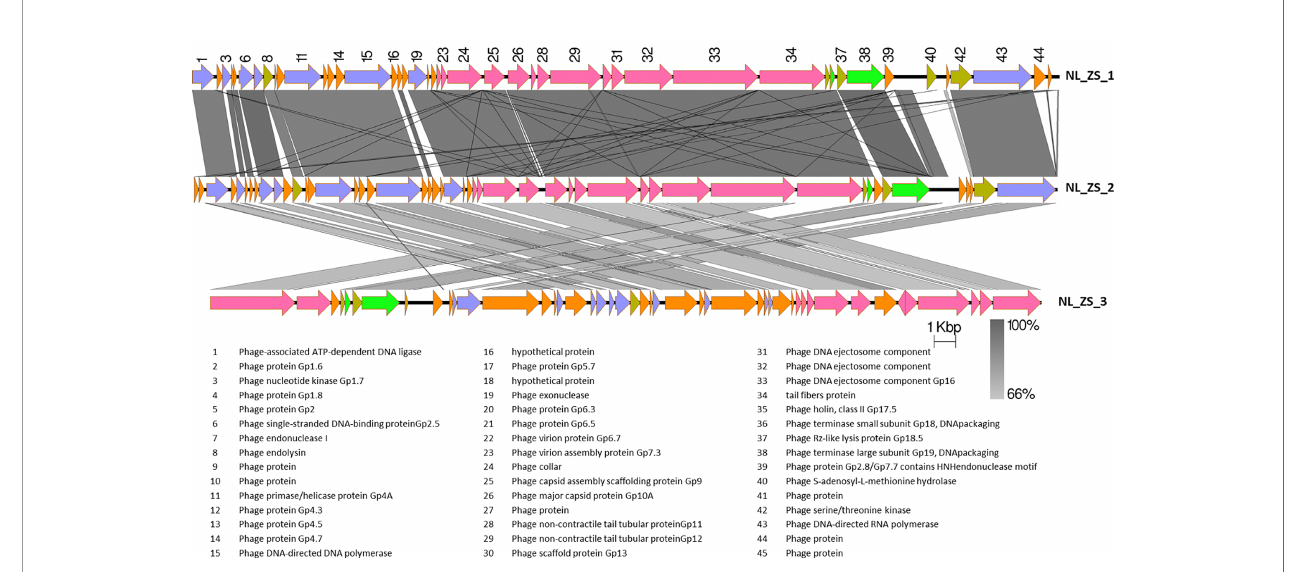
FIGURE 4 | The comparison of the whole genome sequences among three K. pneumoniae phages (NL_ZS_1, NL_ZS_2, and NL_ZS_3) with Easy fi g using the BLASTN algorithm. Grey lines connect regions indicates nucleotide identity >66%, and are gradient-colored according to their similarity; darker shade of grey represents higher identify. The designation of the open reading frames of NL_ZS_1 is shown on the top. Conserved ORFs are color-coded with blue arrows representing the DNA replication module, yellow arrows representing host cell lysis module, pink reparenting the capsid and tail morphogenesis module, green arrows representing the DNA packaging module, and borrow arrows represent genes with no known function.